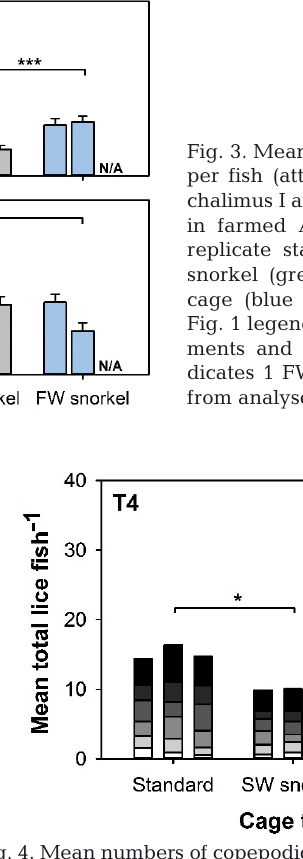
Fig. 4. Mean numbers of copepodids, chalimus I, chalimus II, preadult I, preadult II and adult lice per fish (later stages in increasingly darker shades from white to black) in farmed Atlantic salmon for each replicate standard, SW snorkel and FW snorkel cage at Time 4. See Fig. 1 legend for details of cage treatments and sampling times. N/A represents 1 FW snorkel cage discarded from analyses. *p < 0.05 Table 1. Mean (±SE) values for condition of farmed Atlantic salmon Salmo salar in southwest Norway held in standard cages, and in snorkel cages filled with seawater (SW snorkel) or freshwater (FW snorkel). Higher values for condition factor and overall Semantic Welfare Index Model (SWIM) score in- dicate better condition. Individual welfare indicator scores show proportions of individuals with high scores indicating deviance from the normal